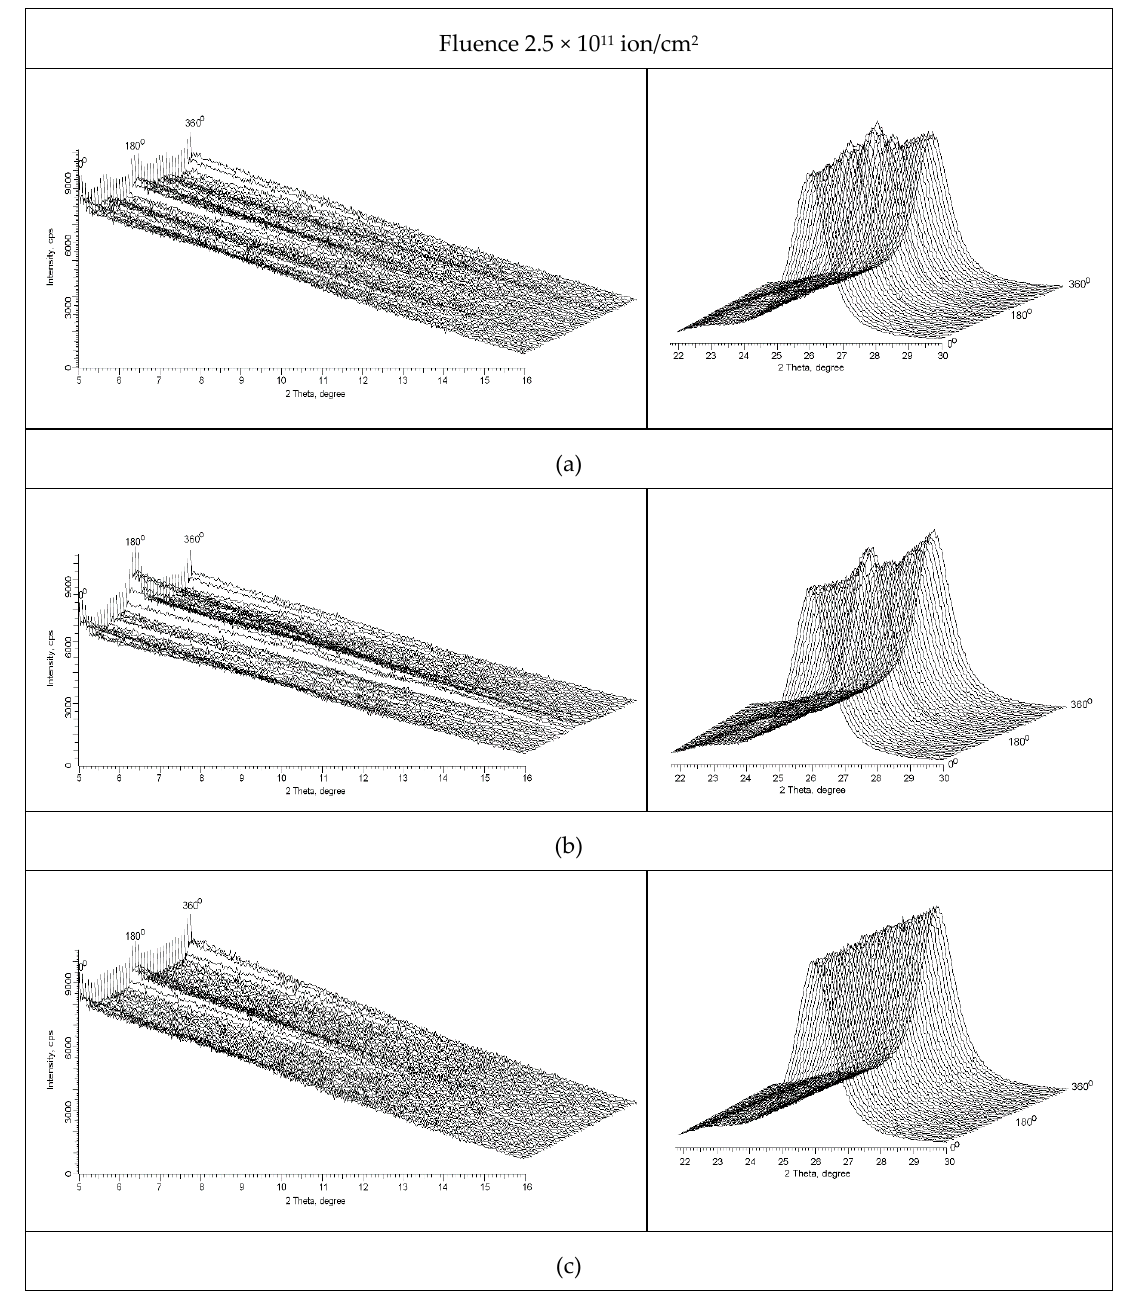
Figure 6. X-ray di ff raction patterns of test samples polymer films: ( a ) irradiated Kr 13 + ions; ( b ) irradiated Figure 6. X-ray diffraction patterns of test samples polymer films: ( a ) irradiated Kr 13+ ions; ( b ) irradiated Kr 14+ ions; ( c ) irradiated Kr 15+ ions. Kr 14 + ions; ( c ) irradiated Kr 15 +